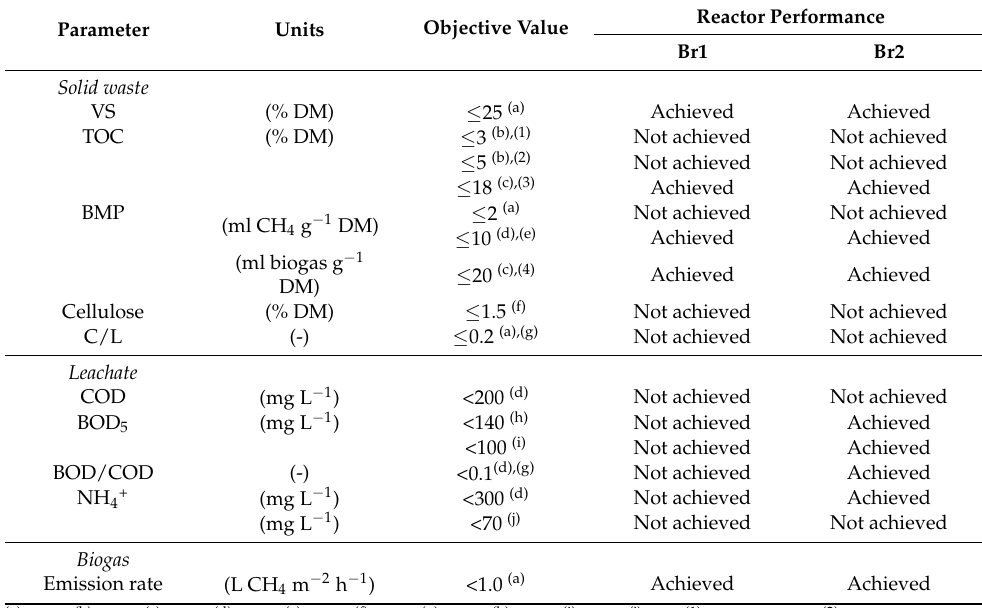
Table 5. Stability characteristics of EW at the end of bioreactor